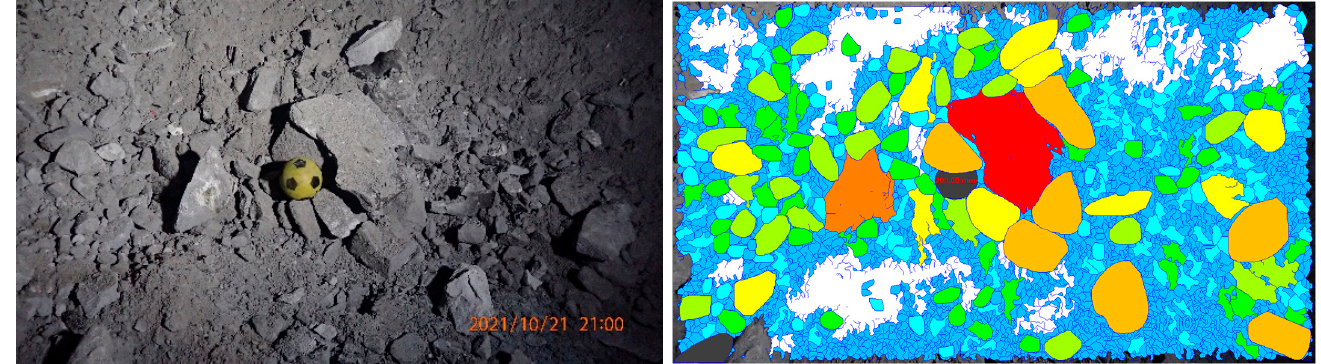
Figure 6. Sample photo of muckpile cross-section with a scaling ball ( left ) and part of the delineation process ( right ).